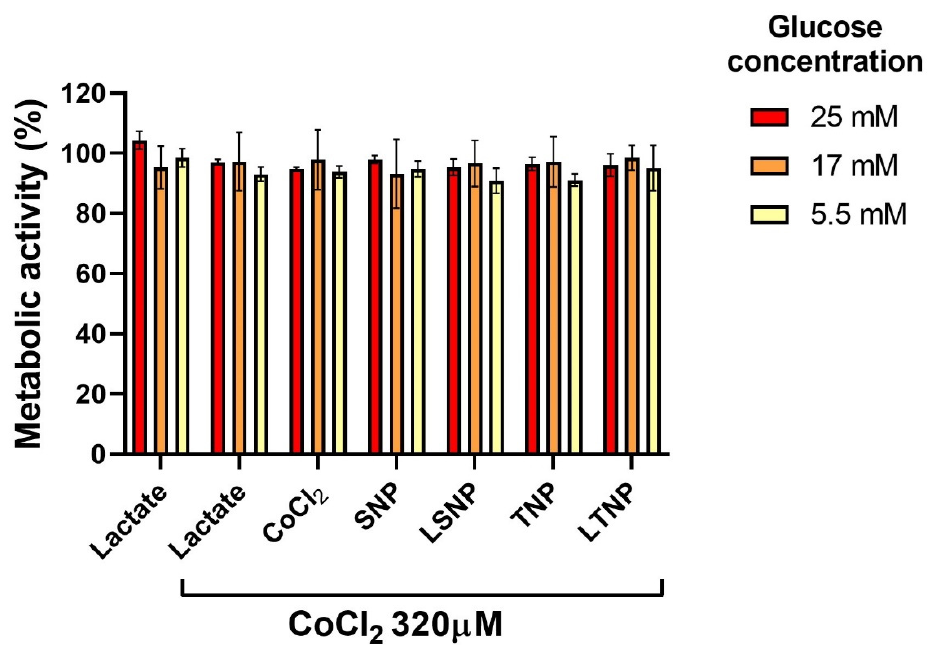
Figure 6. The decrease in cell metabolic activity induced by nanoparticles is inhibited during hypoxia. C6 cells were cultured under chemical hypoxia with 320 µ M of CoCl 2 and a glucose concentration of 5.5 mM, 17 mM, and 25 mM and treated with 100 µ g/mL of nanoparticles for 72 h. Dehydrogenase-dependent metabolic activity was measured by MTT reduction assay. Bars show mean percentage vs. control without CoCl 2 ± SEM of three independent experiments in triplicate, n = 9 (statistical analysis with one-way ANOVA after logarithmic transformation).